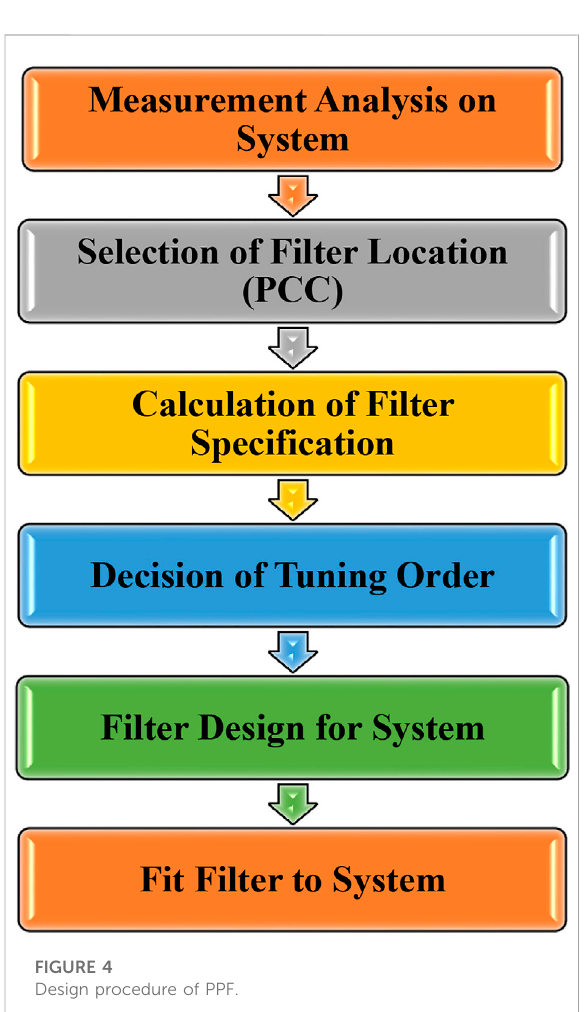
FIGURE 4 Design procedure of